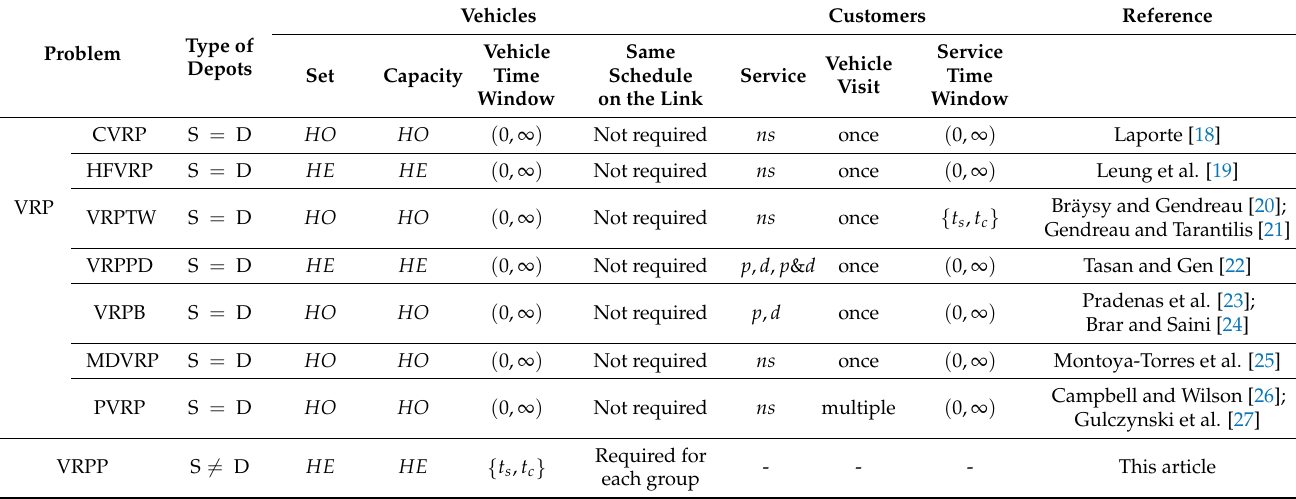
Table 3. Comparison between VRP variants and